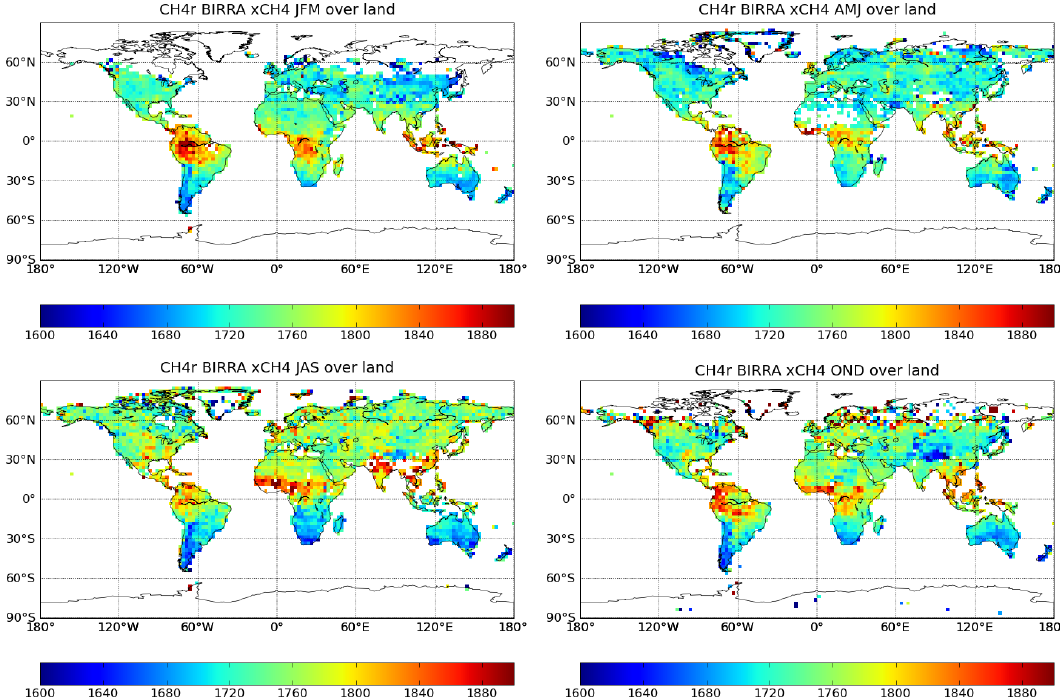
Fig. 21. Quarterly means of methane [ppm] for 2004. In view of the reduced signal over oceans, only CH 4 over land is plotted. (2 ◦ × 2 ◦ grid)